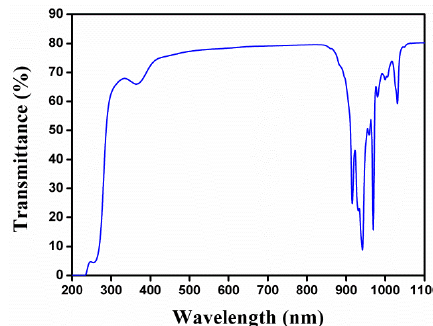
Fig. 4 Transmittance of YAG transparent ceramic specimen.